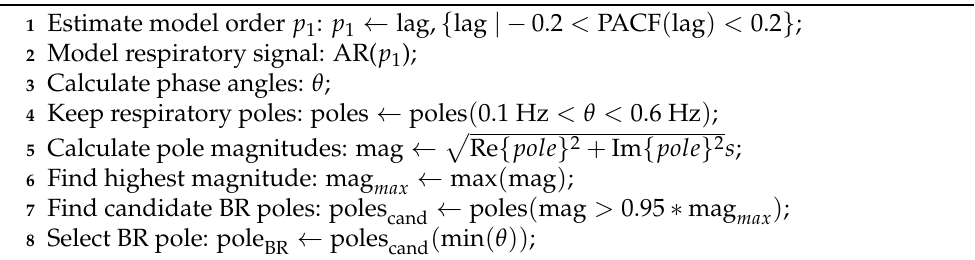
Algorithm 2: Improved Pole Magnitude and Phase Angle